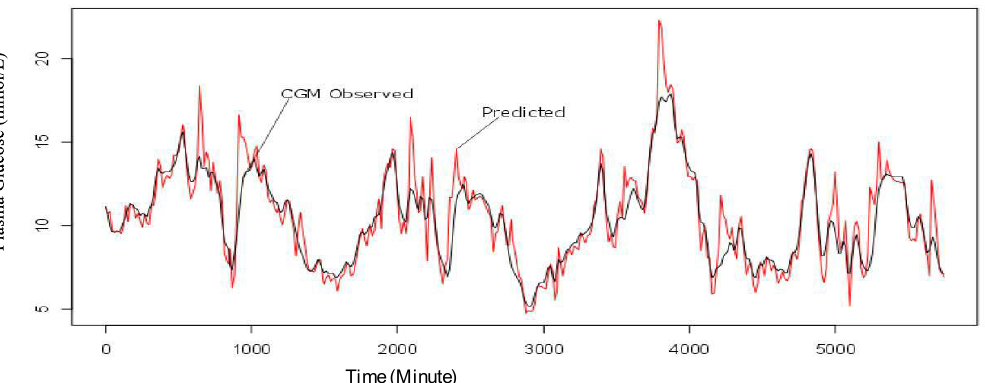
Figure 5. CGM observed and one ‐ step predicted values trend for plasma glucose for 24 h on the first day of the experiment.